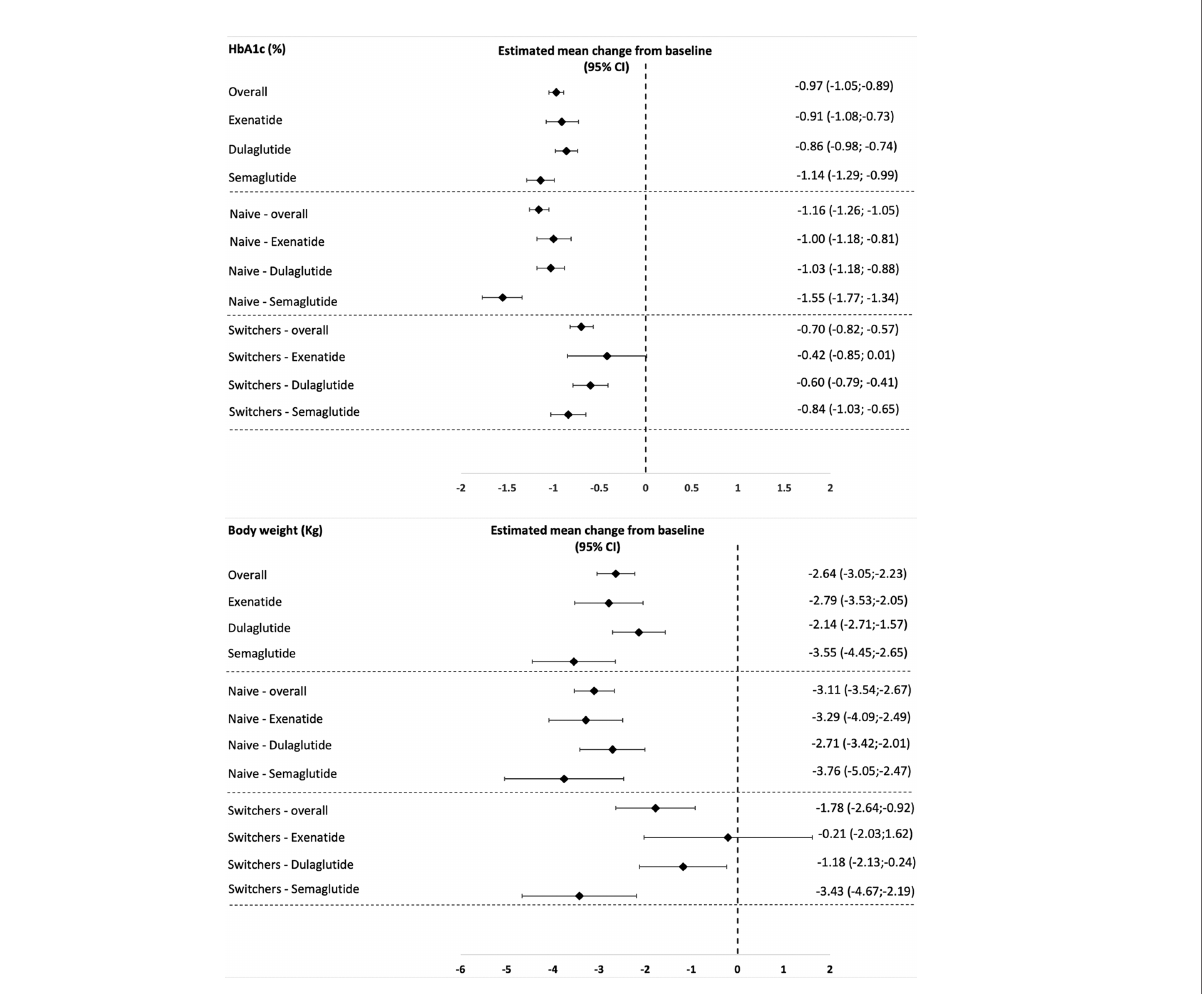
FIGURE 1 | Estimated mean changes from baseline in HbA1c and body weight in the different study populations.